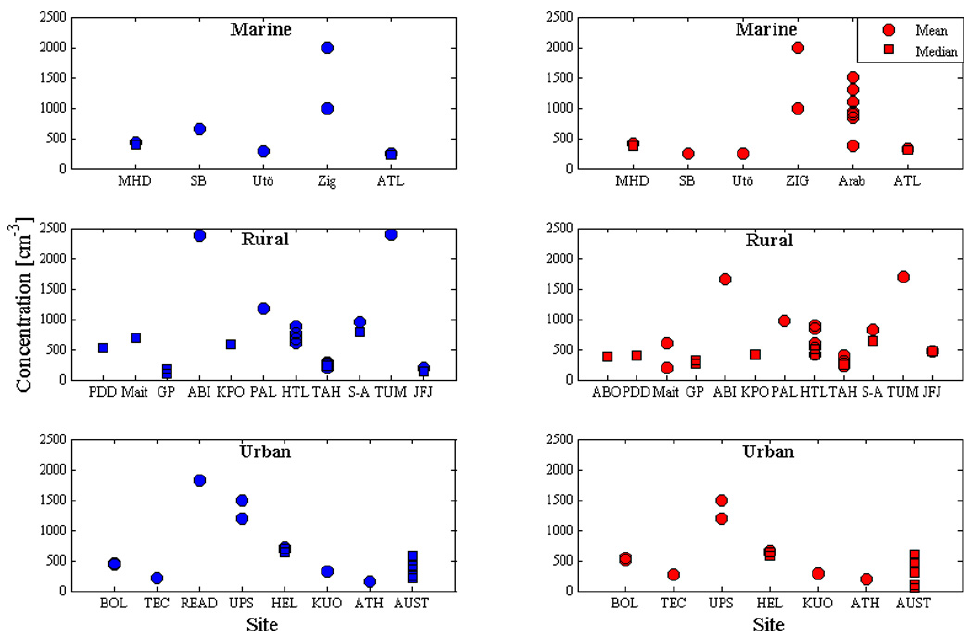
Fig. 6. The mean and median concentrations of small ions as a function of site in marine (top panel), rural (middle panel) and ur- ban (bottom panel) environments based on measurements on the ground. Red markers are for positive and blue markers for negative ions. MHD=Mace Head, SB=San Se=Puy de Dˆome, Mait=Maitri, GP=Garmisch-Partenkirchen, ABI=Abisko, KPO=K-Puzsta, PAL=Pallas, HTL=Hyyti¨al¨a, TAH=Tahkuse, S-A=South-Africa, TUM=Tumbarumba, ABO=Aboa, JFJ=Jungfraujoch, BOL=Boulder, TEC=Tecamac, Read.=Reading University, Ups=Upsala, HEL=Helsinki, KUO=Kuopio, ATH=Athens and AUST=Australia (Ling et al.,